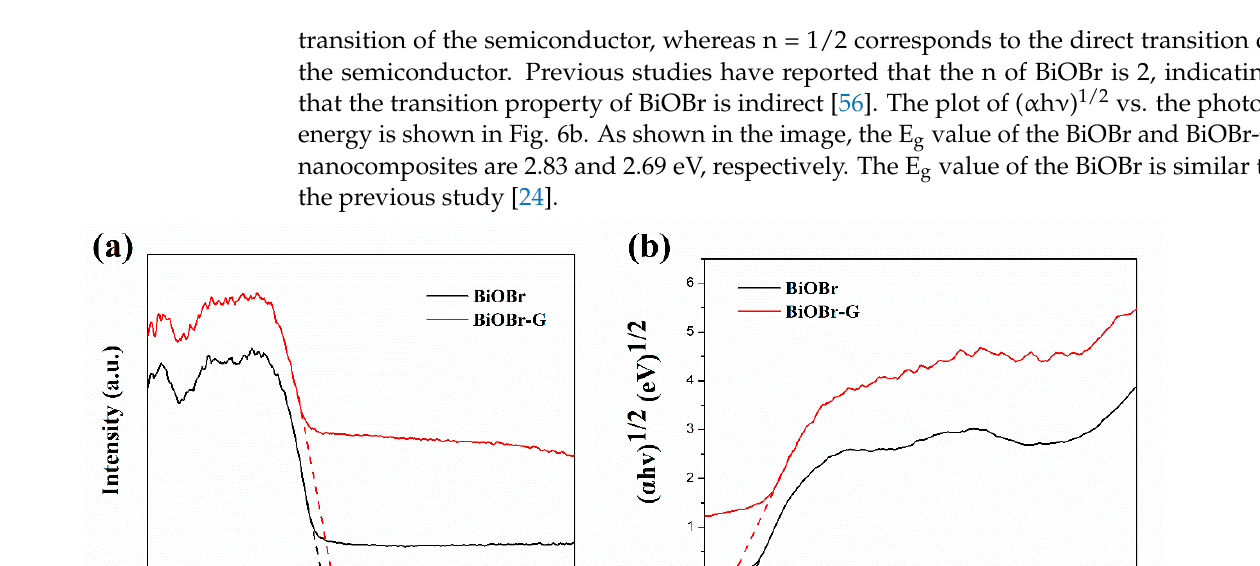
301 Figure 5. SEM images of ( a ) BiOBr and ( b ) BiOBr-G. TEM images of ( c ) BiOBr and ( d ) BiOBr-G.